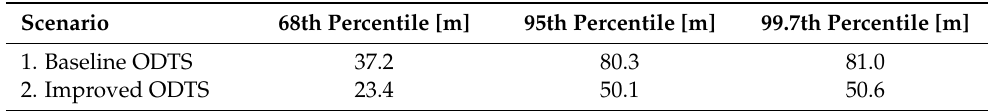
Table 11. Statistics highlighting the improved position accuracy in case of an improved ODTS accuracy. The percentiles refer to the time series of the horizontal uncertainty (3-sigma).